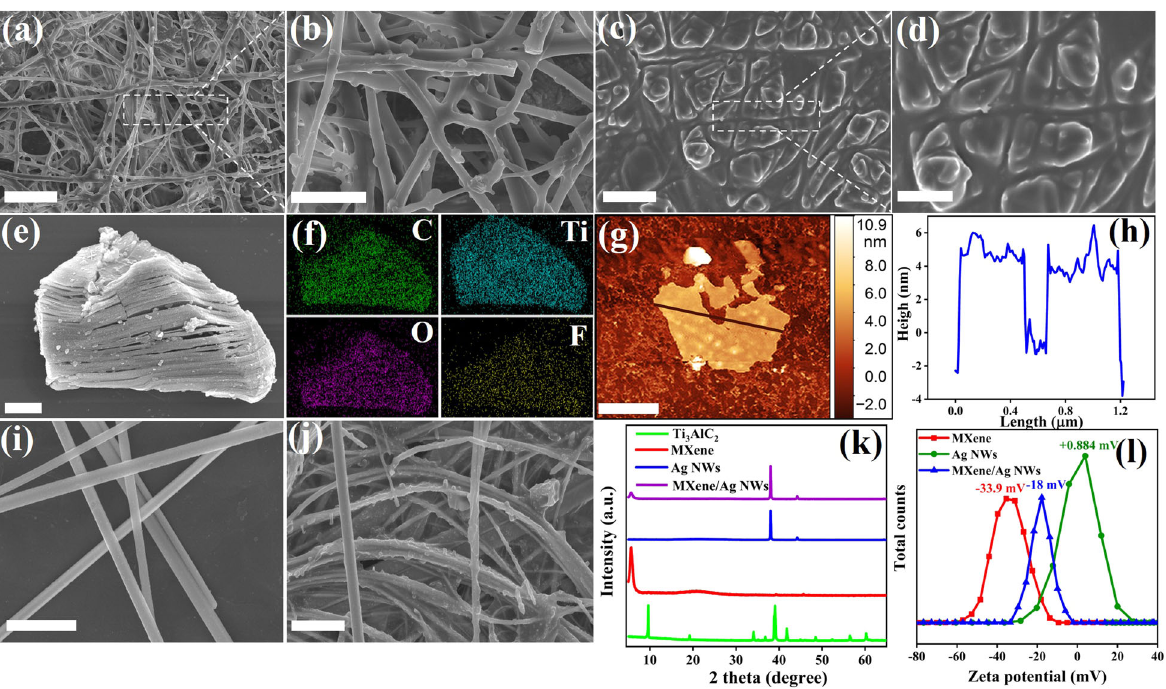
Fig. 2 Morphologies and structure characterization of the electrode materials. a – d SEM images of the ESIM, the PDMS dielectric layer with an inverted microstructure, the scale bars in ( a ) and ( c ) are 20 μ m, that in ( b ) and ( d ) are 10 μ m; e , f SEM image and its corresponding element mapping of the multilayered MXene, the scale bar in ( e ) is 2 μ m; g , h AFM image and the height distribution diagram of the 4 – 5 layer MXene, the scale bar in ( g ) is 500 nm; i , j SEM images of pristine Ag NWs and the composite, the scale bars in ( i ) and ( j ) are 1 and 2 μ m, respectively; k XRD patterns of Ti 3 AlC 2 , MXene, Ag NWs, and MXene/Ag NWs composite; l Zeta potentials of MXene, Ag NWs, and the